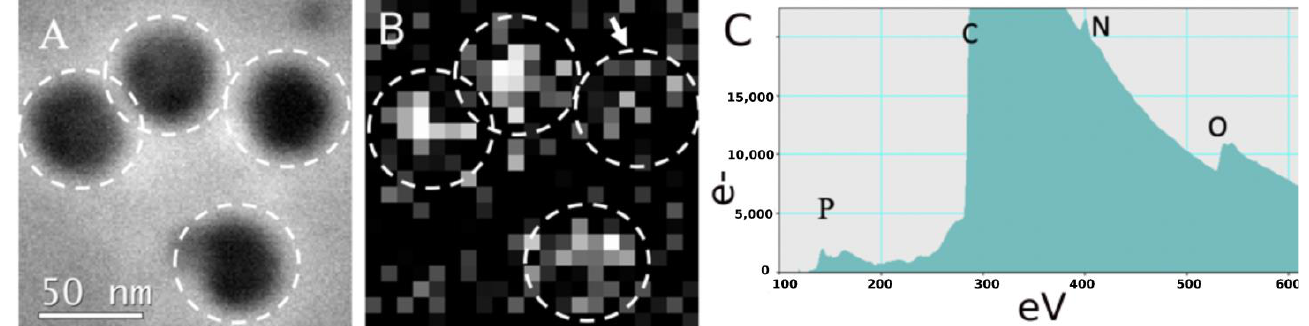
Figure 4. STEM-EELS analysis of TBEV. (A) STEM image of tick-borne encephalitis virus virions, (B) map of phosphorus EELS signal distribution in the same sample; white dotted lines indicate virion boundaries and arrow indicates virion with lower phosphorus signal, and (C) EELS spectrum from one representative virion. Letters indicate the spectrum edge positions for corresponding elements: P — phosphorus, C — carbon, N — nitrogen, and O — oxygen.